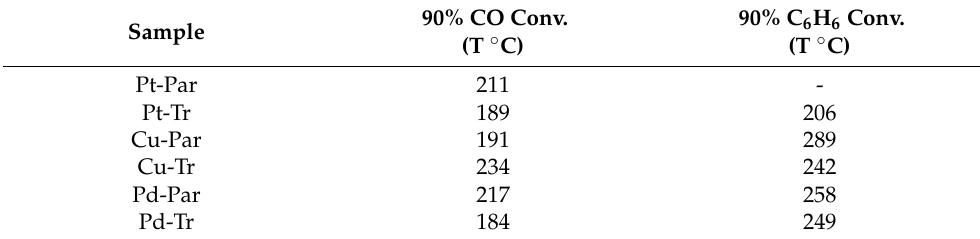
Table 2. Catalytic activity in CO and benzene oxidation.